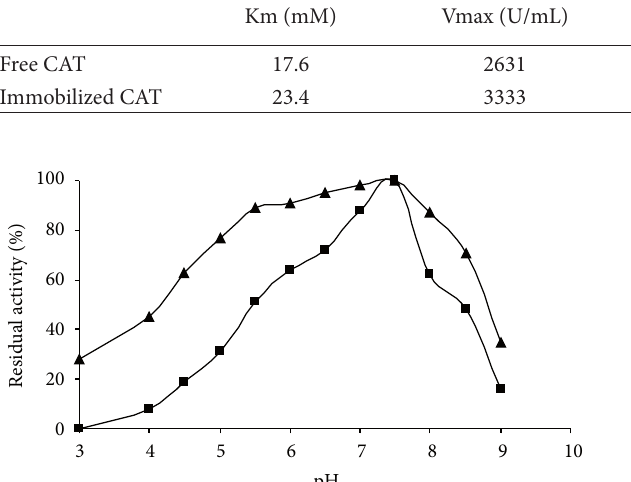
F 4: Storage stability at 4